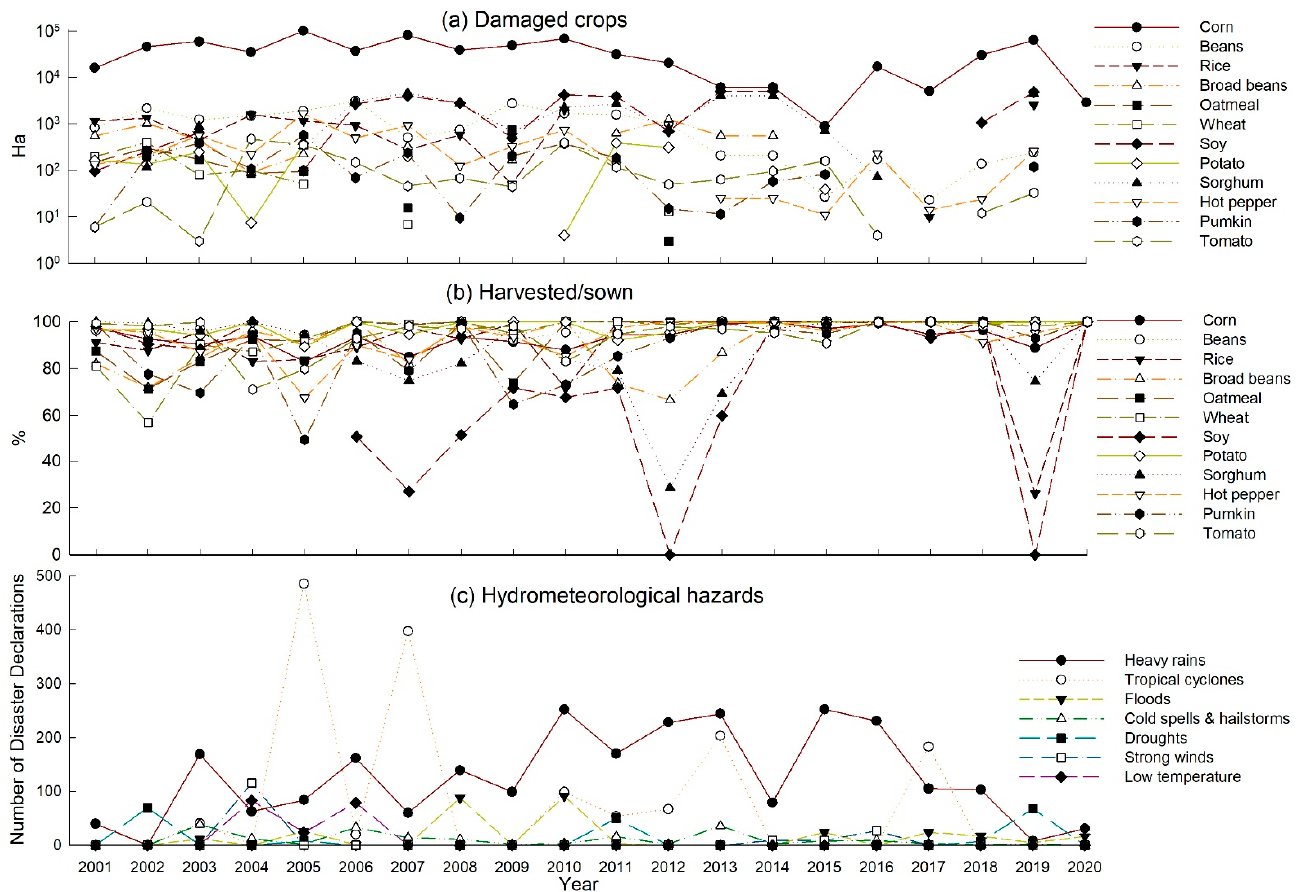
Figure 6. Damaged crop areas and hydrometeorological phenomena with disaster declarations in the State of Veracruz from 2001 to 2020. ( a ) Number of damaged hectares; ( b ) number of disaster declarations by year. Source: based on data from the Mexican National Center to Prevent Disasters statistics [15] and the Mexican National Agrifood System [5].